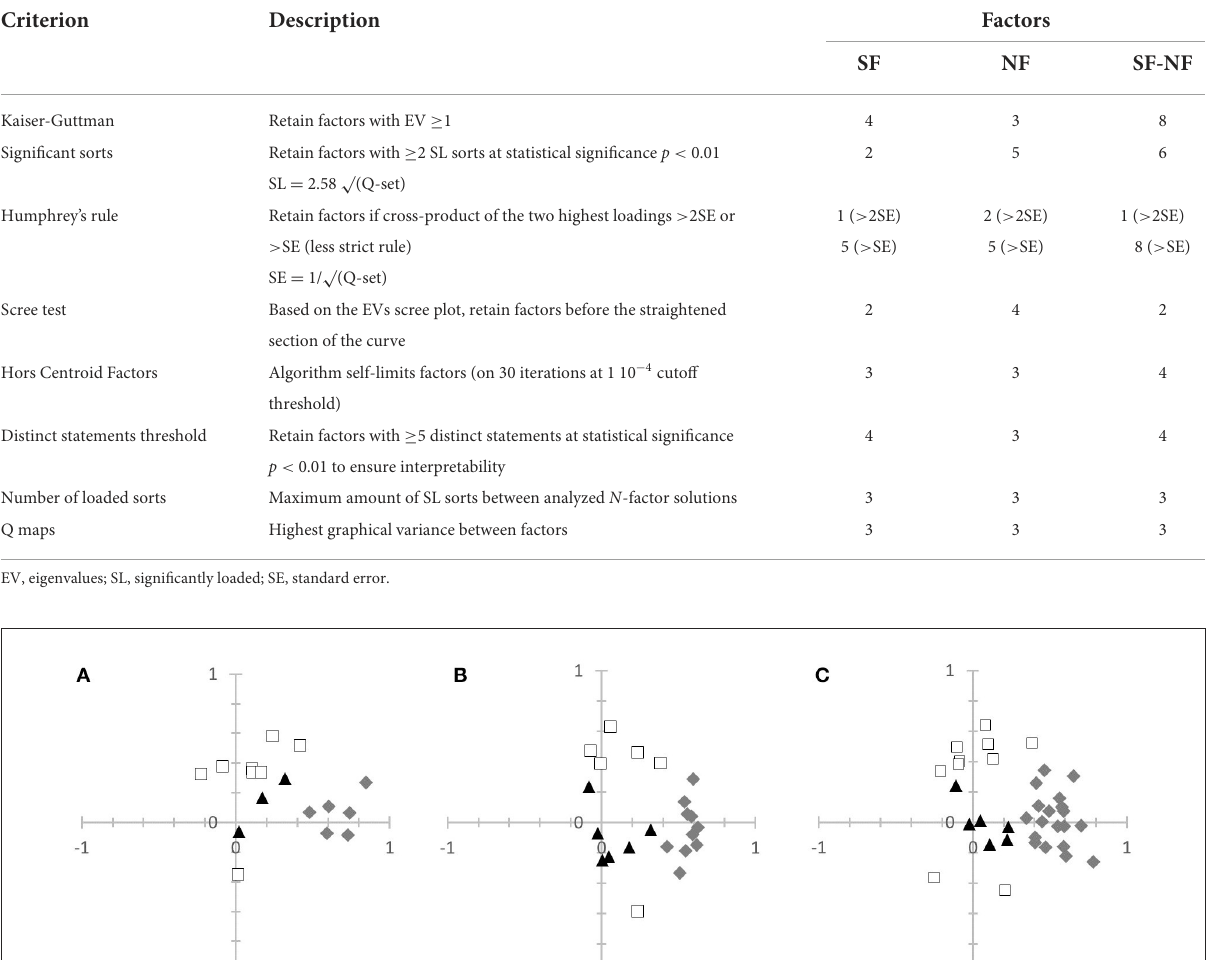
TABLE 5 Factor retention criteria, description and